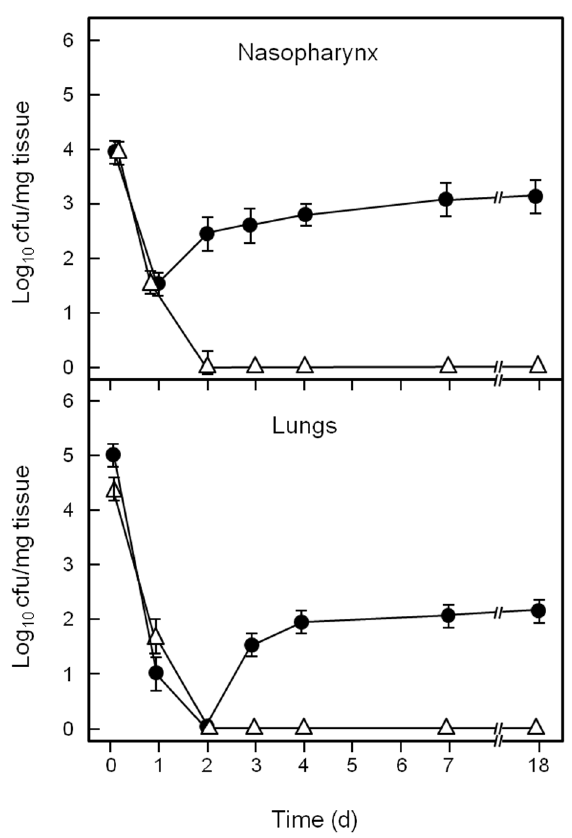
Figure 1. Bacterial numbers (cfu) within nasopharynx or lungs at various times following intranasal challenge of mice (1 6 10 8 cells) with S.pyogenes MGAS10270 ( N ) or MGAS10270 aspA ( D ) (UB2115). Data are means 6 SEM of 3 experiments.